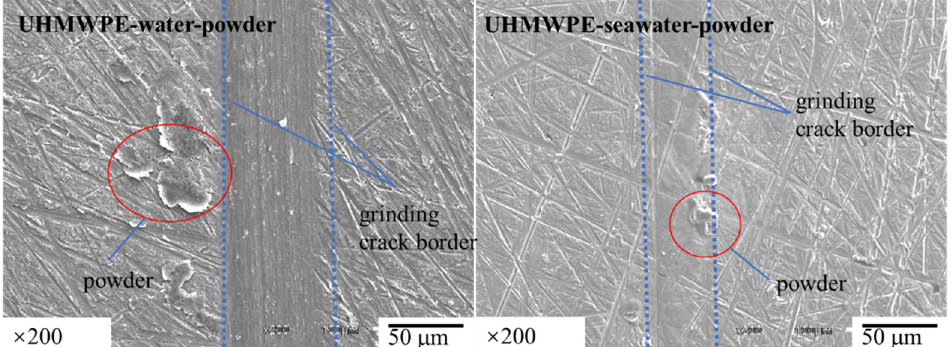
Figure 6. SEM images of wear marks on 1a90 aluminum plate matched with UHMWPE pins in solution with powder. Table 5. Element analysis of wear marks on the aluminum